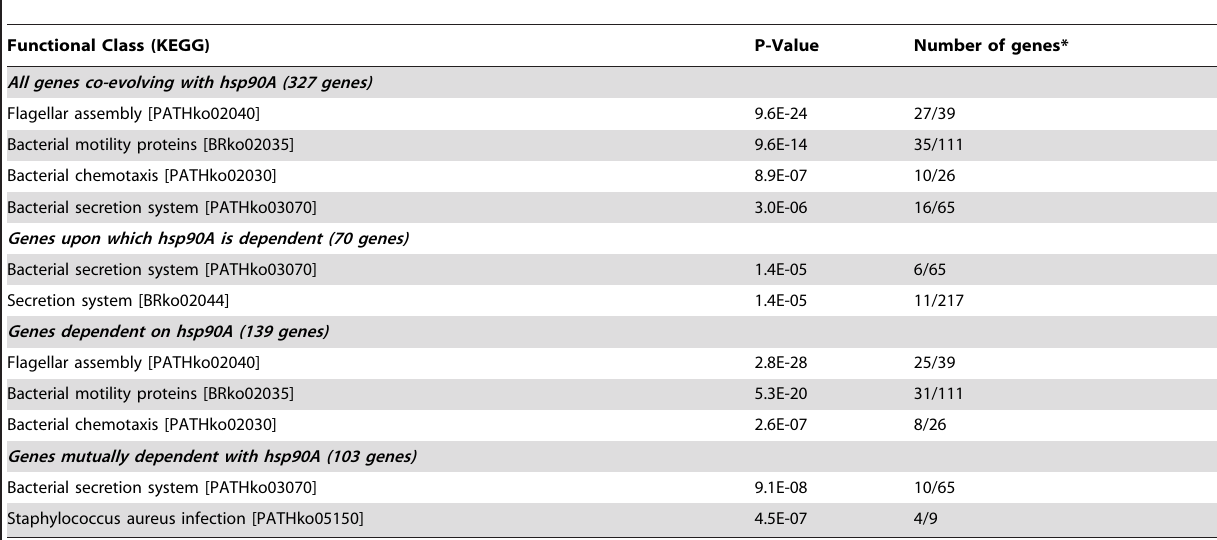
Table 1. Functional enrichments in the classes of hsp90A -associated